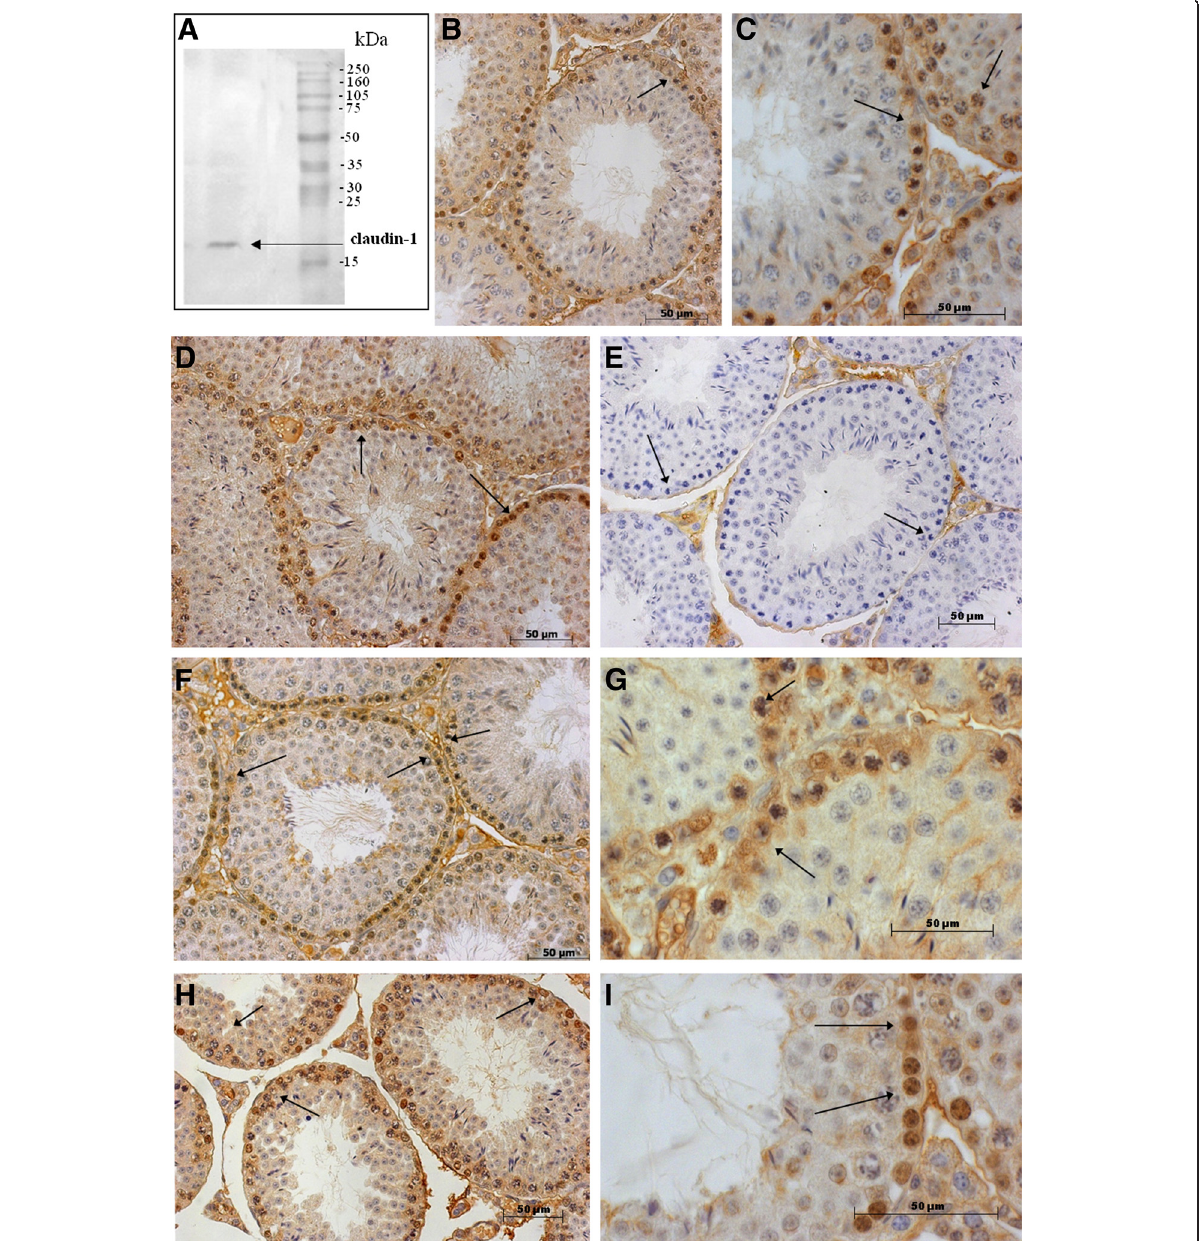
Figure 3 Effects of BPP-10c and captopril on the distribution of claudin-1 in the seminiferous epithelium of adult mouse testis. (A) Immunoblot analysis of mouse testis lysate using an antibody to claudin-1. (B, C, D) Immunohistochemical staining of mouse testis transverse cross-sections treated with vehicle. (E) Non-specific staining was detected only in the basal and adluminal compartments of seminiferous epithelium of control sections – negative control. (F and G) Immunostaining of claudin-1 following treatment with captopril or (H and I) BPP-10c demonstrated no difference in the distribution of claudin-1 when compared with control. Hematoxylin was used for counterstaining. Scale bar: 50 μ